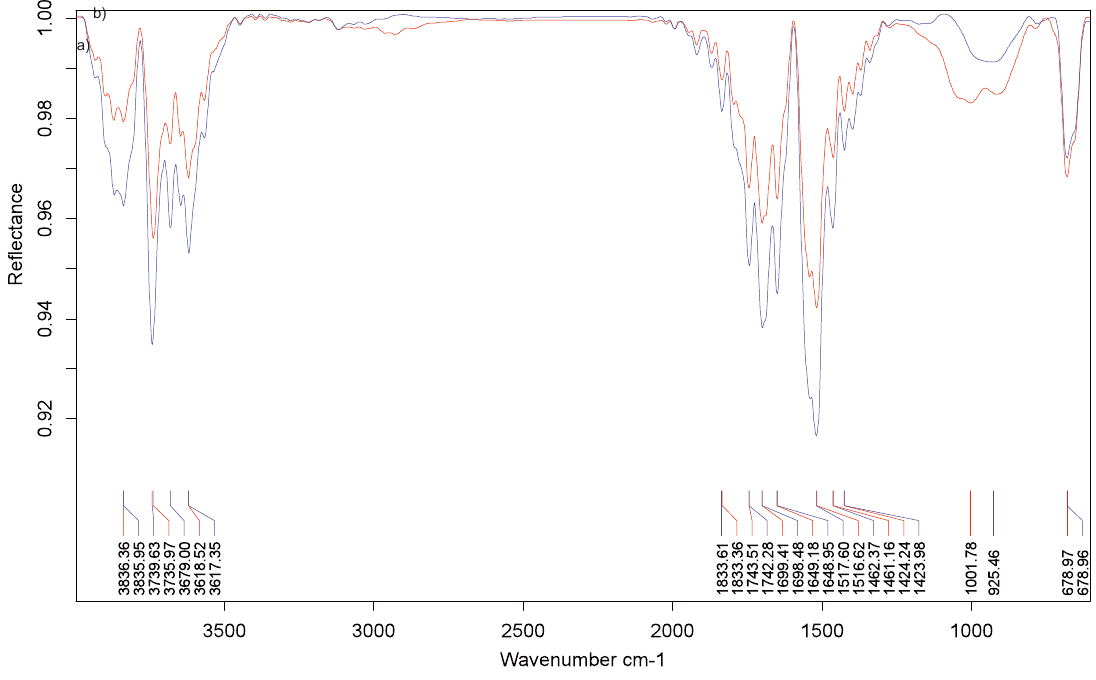
Figure 8. FTIR spectra for samples a) 341____ and b) 345___ (Baltic amber